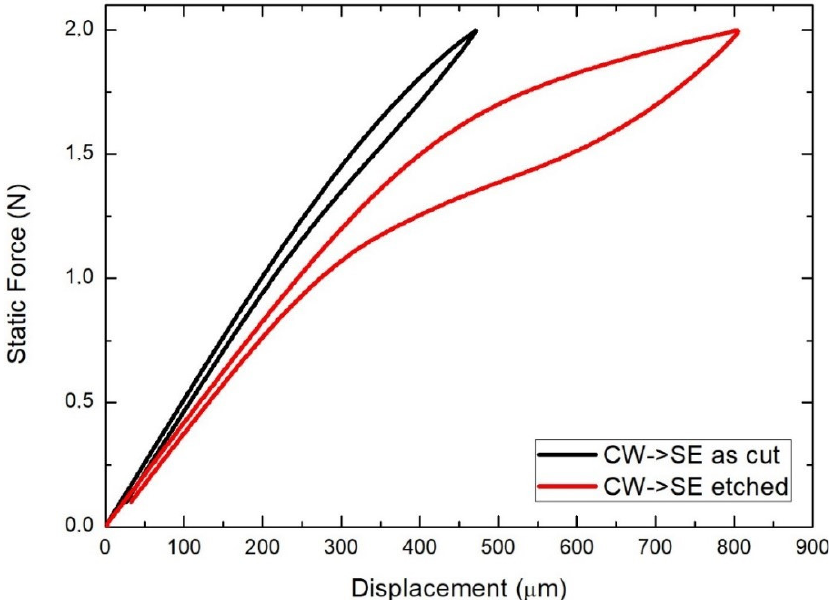
Figure 13. Static force/displacement curve for a diamond-like element cut from CW sheet before and after chemical etching.